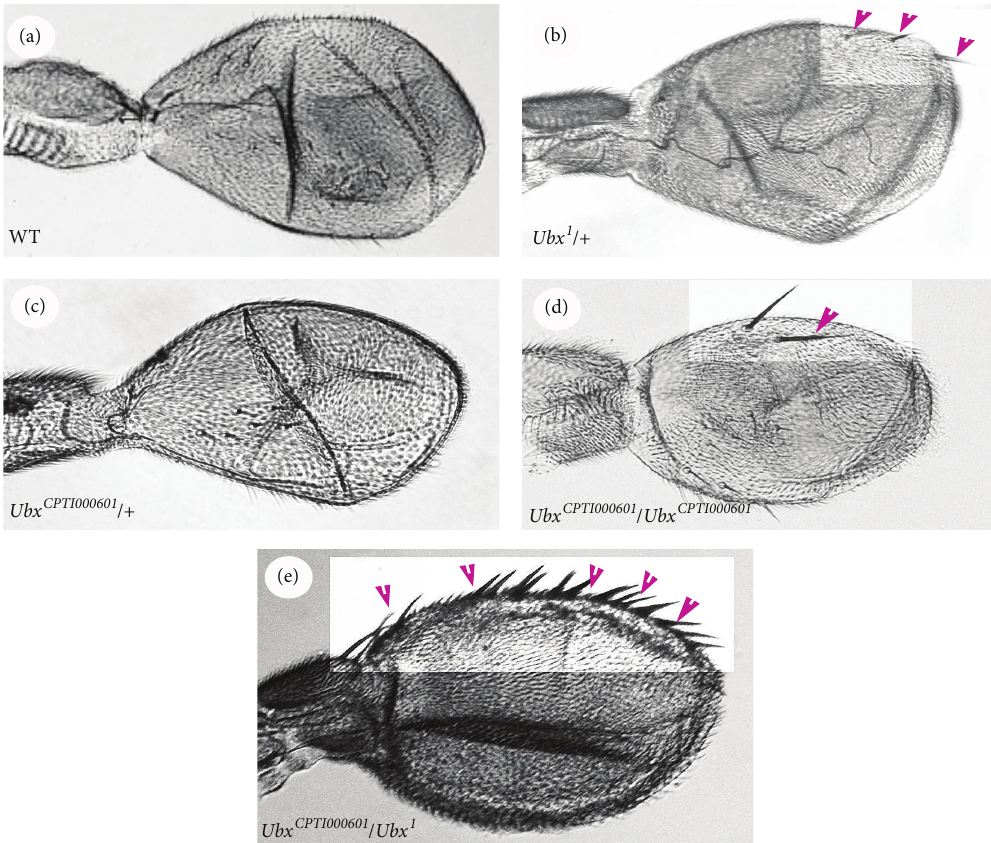
Figure 6: Comparison between wild type Ubx CPTI000601 and Ubx 1 halteres. (a) Wild type haltere. (b) Ubx 1 /+ haltere. Several marginal bristles are observed. (c) Ubx CPTI000601 /+ haltere. (d) Ubx CPTI000601 / Ubx CPTI000601 haltere. (e) Ubx CPTI000601 / Ubx 1 haltere. Wing-like marginal bristles are observed. Purple arrowheads indicate bristles.